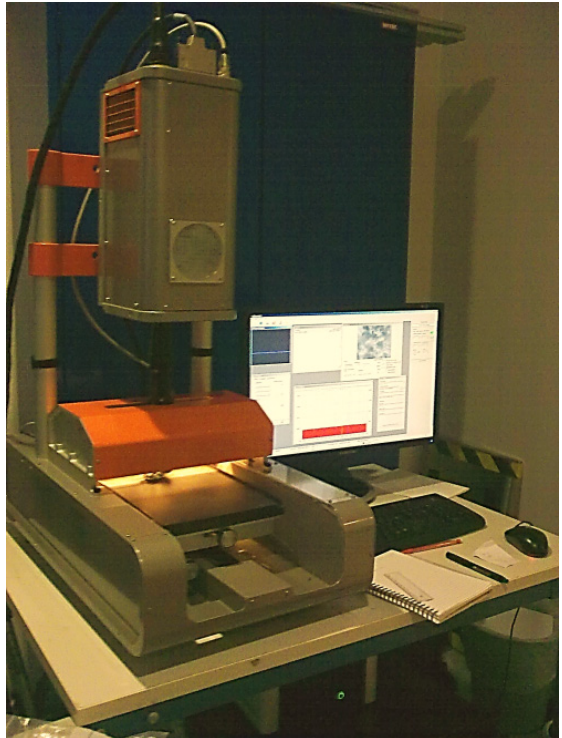
Figure 1. An integrated system of SisuCHEMA hyperspectral scanner